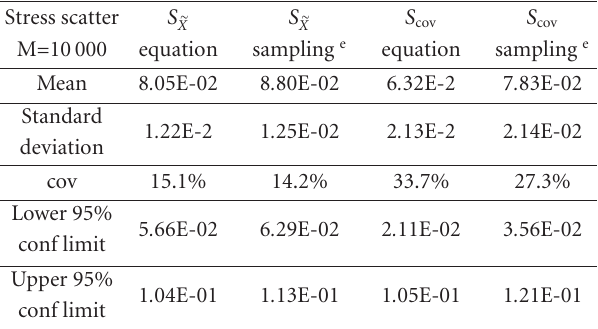
Table 3: Comparison of variation of sensitivity estimates equation versus statistical trial-stress scatter random